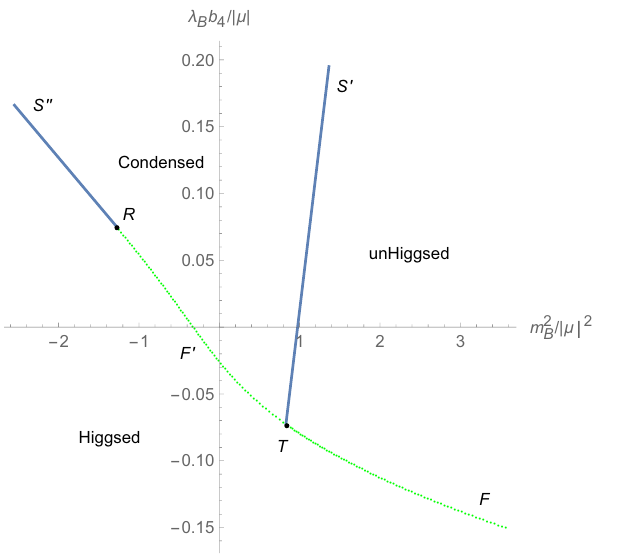
Figure 20 . The phase diagram of the regular boson theory for | λ B | = 1 it is in the stable range φ h < x B